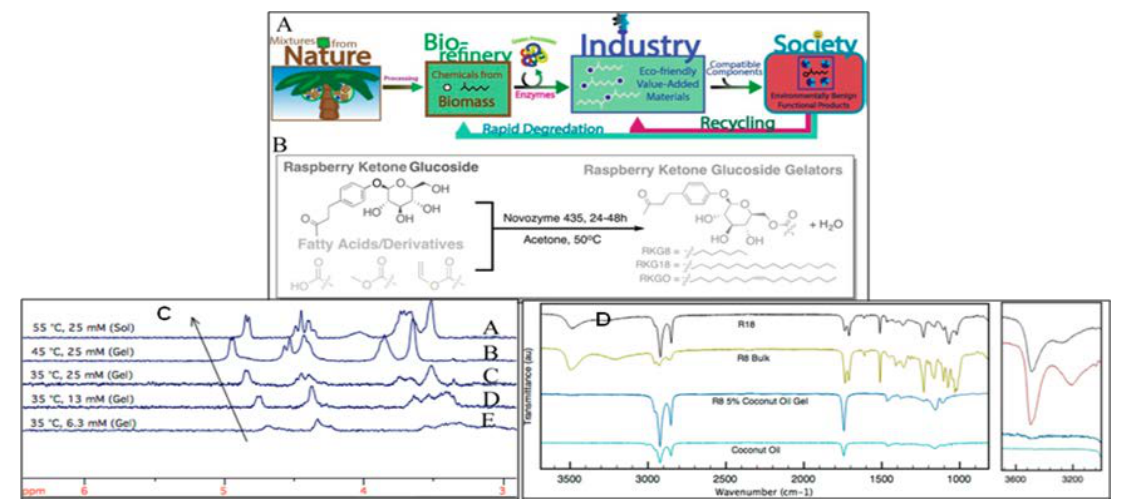
Figure 35. ( A ) Schematic demonstration of the combined biorefinery model with green chemistry principles, extracting reagents from waste and biomass resources to develop functional materials from value-added chemicals; ( B ) synthetic scheme for the development of novel medium- and long-chain triglyceride gelators following the model; ( C ) 1H NMR spectra of RKG8 mixtures in toluene: a close-up on the shifting carbohydrate peaks. The bottom spectra (B–E) are in the gel state, and the top spectrum (A) is a solution. There is a shift in the pyranose hydrogen at the C1 position δ 4.9 following the stretched hydrogen bond in the gel that then relaxes when the molecules are in solution.; ( D ) (Left) FTIR spectra of oleogel and bulk gelators samples; (right) hydrogen bonding region displays weak O–H peaks in the gel spectrum. Reprinted with permission from [139]. Copyright 2015 American Chemical